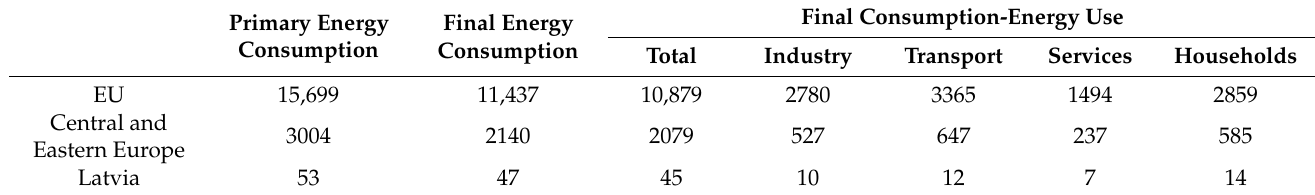
Table 1. Comparison of energy consumption in EU, Central and Eastern Europe and Latvia in 2019, TWh